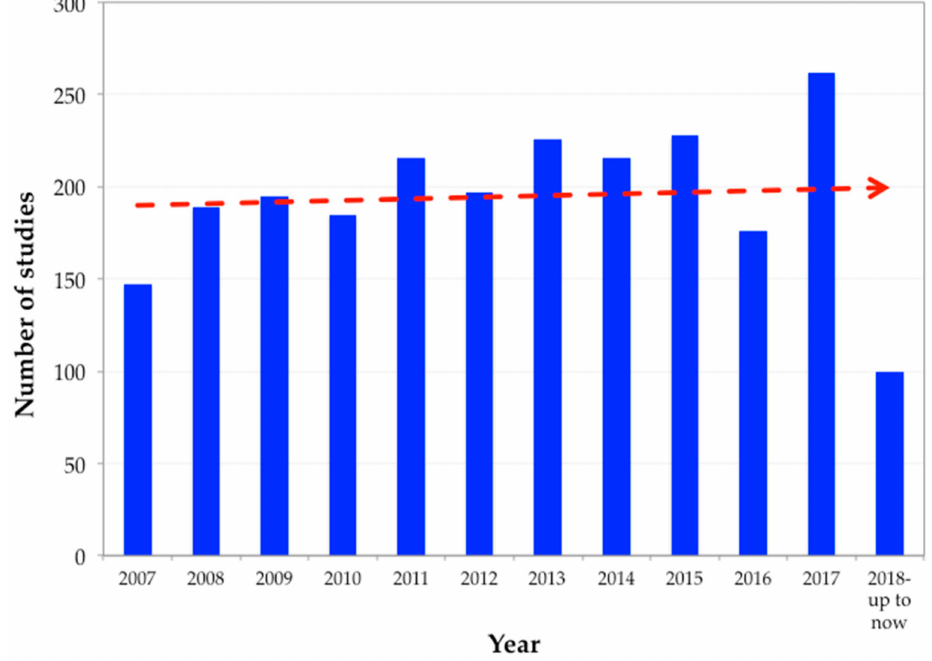
Figure 3. Evolution of the number of studies over the last decade using zeolites for separation applications (source: wwww.scopus.com, 8 May